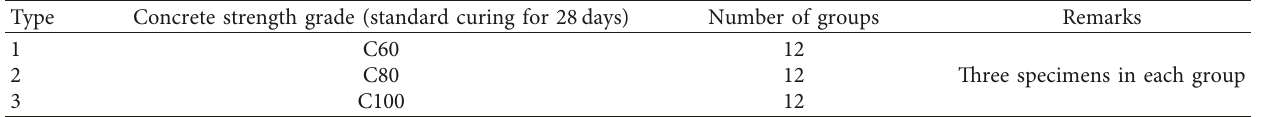
Table 1: Types and number of concrete specimens.